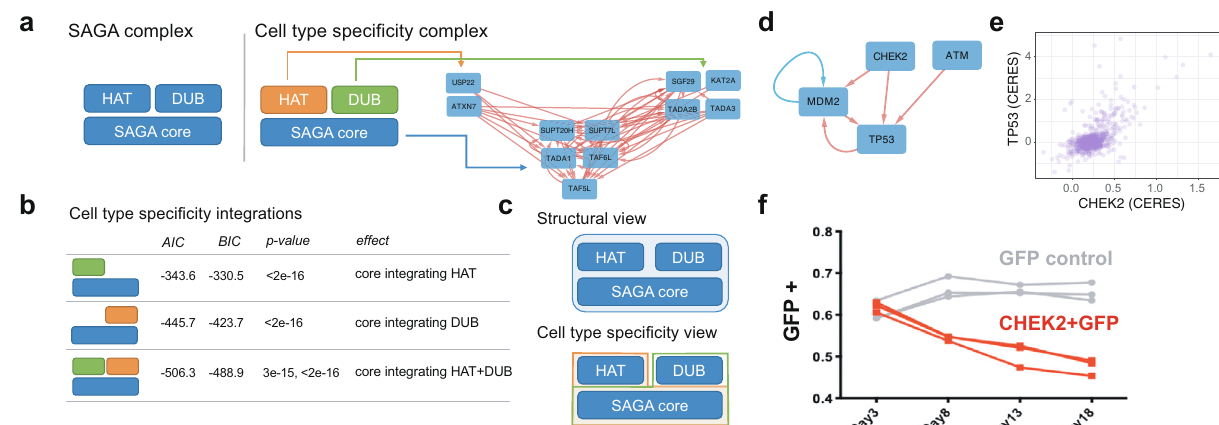
Fig. 4 Two vignettes on cell-type-speci fi c prediction networks. a A simplistic diagram of key functional modules in the SAGA complex includes a Histone Acetyl Transferase (HAT) module, a De-Ubiquitinating (DUB) module and core complex members (SAGA core) that are thought to be structural. The subnetwork to the right was extracted from a Louvain community containing the SAGA complex and its associated enzymatic modules. The edges are predictive relationships of CERES scores in our fi nal models. When comparing the density of the edges between functional modules, the sparsity of the red edges between HAT and DUB modules is visually striking (comparing green to orange vs. green to blue and orange to blue). b A simple multivariate linear regression model (for interpretability) was used to rationalize the network structure. The aggregate measures of cell-type-speci fi c phenotypes for each functional model were created by averaging the CERES scores of individual genes in each module from ( a ). HAT or DUB, as well as HAT and DUB cell-type- speci fi c features, were found to be independent predictors of the cell-type-speci fi c phenotype of the SAGA core complex (measured by the Akaike information criterion (AIC), Baye ’ s information criterion (BIC), and P value of model coef fi cients based on two-sided t tests). c A diagram of the difference between the static, structural, view of the SAGA complex that suggests an integrated molecular machine that is built from its constituent modules, and a cell-type speci fi city view of the SAGA complex that suggests plasticity in module requirements across cell lines is genetically integrated by the SAGA core. d CHEK2 and TP53 interactions in our functional networks are presented from their Louvain community. Red arrow are CERES prediction relationships and the blue arrow is an RNA-seq feature. e CERES scores for TP53 and CHEK2 across all cell lines in the Broad institute ’ s dependency map data (19Q3). f To demonstrate the role of CHEK2 in the absence of DNA damage in already transformed cell lines, we performed an “ add back ” experiment where we infected CHEK2 mutant Colo678 cells with a functional copy of CHEK2 marked with GFP. Partially transduced cells can be used to measure fi tness changes via a GFP competition experiment. Partially infected pools are monitored for the GFP + proportion of cells (n = 3 replicates). Depletion occurs when the fi tness of the infected cell decreases. The control is GFP alone. Source data are provided as a Source Data fi